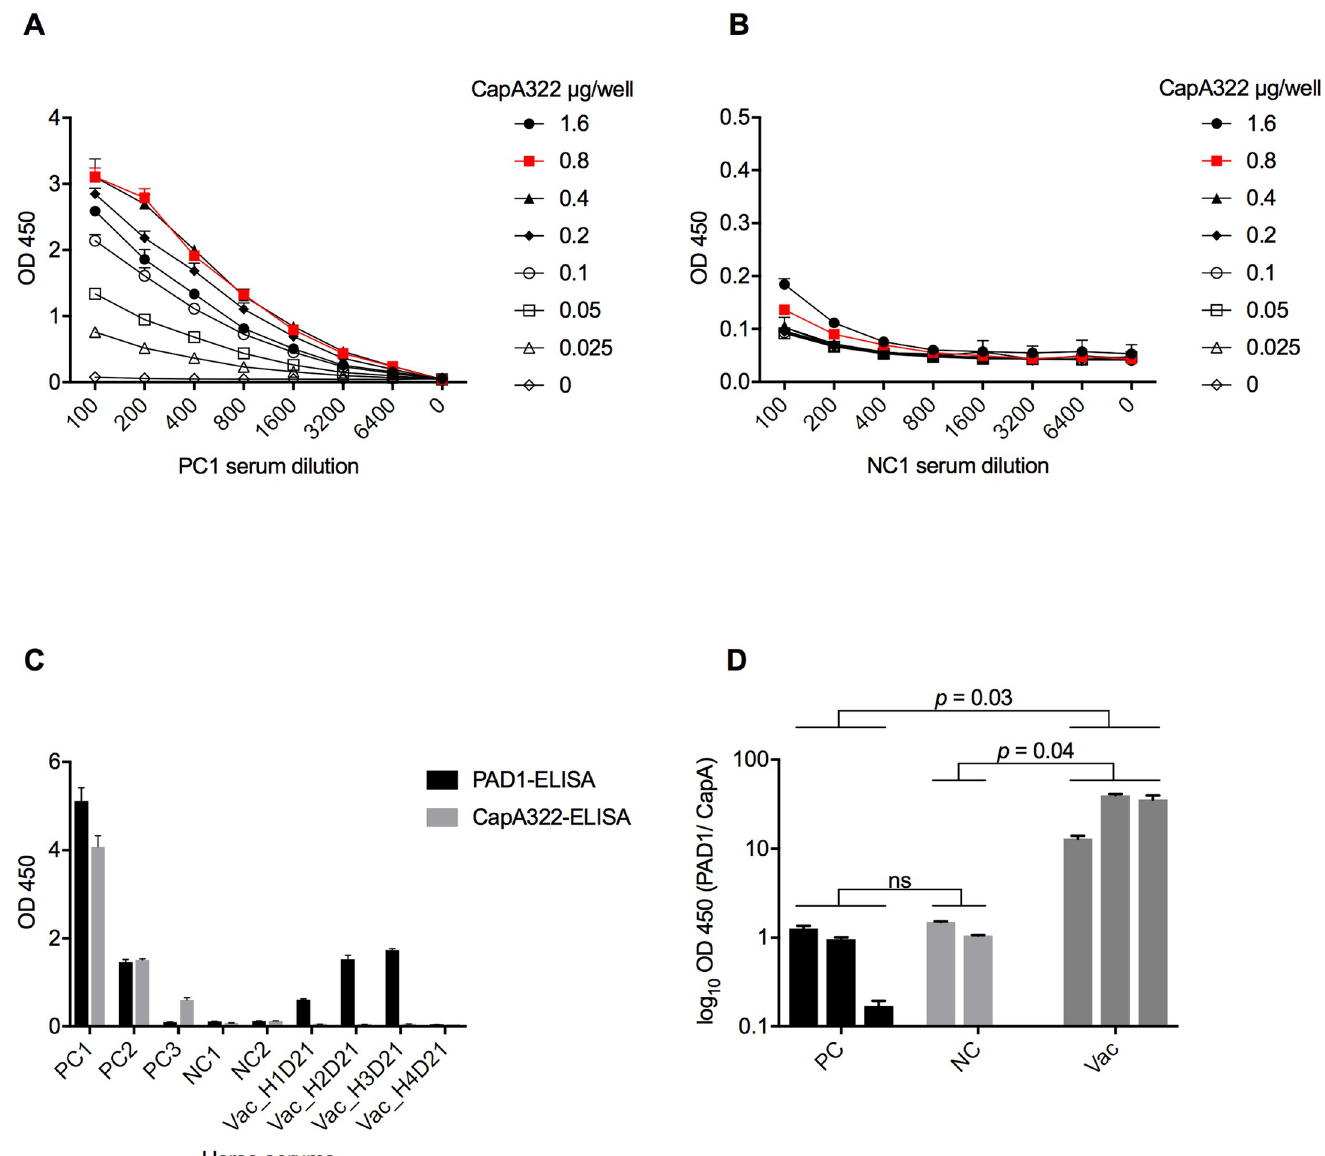
Fig 4. Comparison of PAD1-ELISA and CapA322-ELISA. Checkerboard titration between CapA322 and (A) horse hyperimmunized anti- Bacillus anthracis serum (PC1) or (B) naive horse serum (NC1) in CapA322-ELISA. Each dilution of serum sample was tested in technical triplicate by CapA322-ELISA. The twofold serum dilution starts with a dilution of 1:100, and CapA322 dilution starts with 1.6 μ g/well. From the result, we determined the optimal concentrations of antigen, antibody, and serum dilutions as follows: antigen, 0.8 μ g/well; serum dilution, 1:100; second antibody dilution, 1:15,000. (C) Comparison of PAD1-ELISA and CapA322-ELISA on horse sera. Each serum samples of horse hyperimmunized anti- Bacillus anthracis (PC1), horse naturally infected with B . anthracis (PC2 and PC3), naive horses (NC1 and NC2), and horse vaccinated with Sterne34F2 strain (Vac_H1D21-Vac_H4D21) was analyzed in technical triplicate by PAD1-ELISA and CapA322-ELISA. (D) One-way ANOVA with Tukey’s multiple comparison test on relative OD values of positive (PC; n = 3), negative (NC; n = 2), and vaccinated (Vac; n = 3) groups.